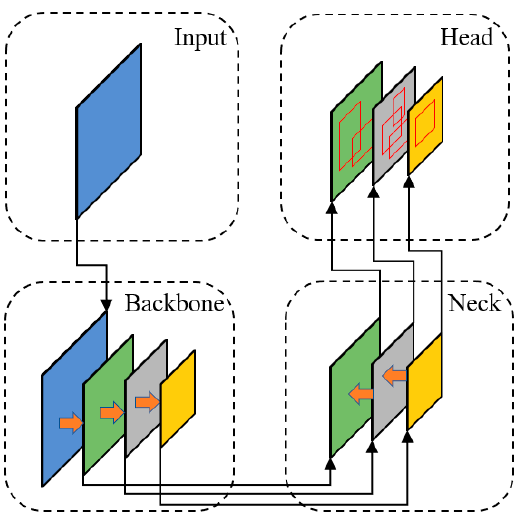
Figure 5. The four parts of the YOLOv5 detection model.